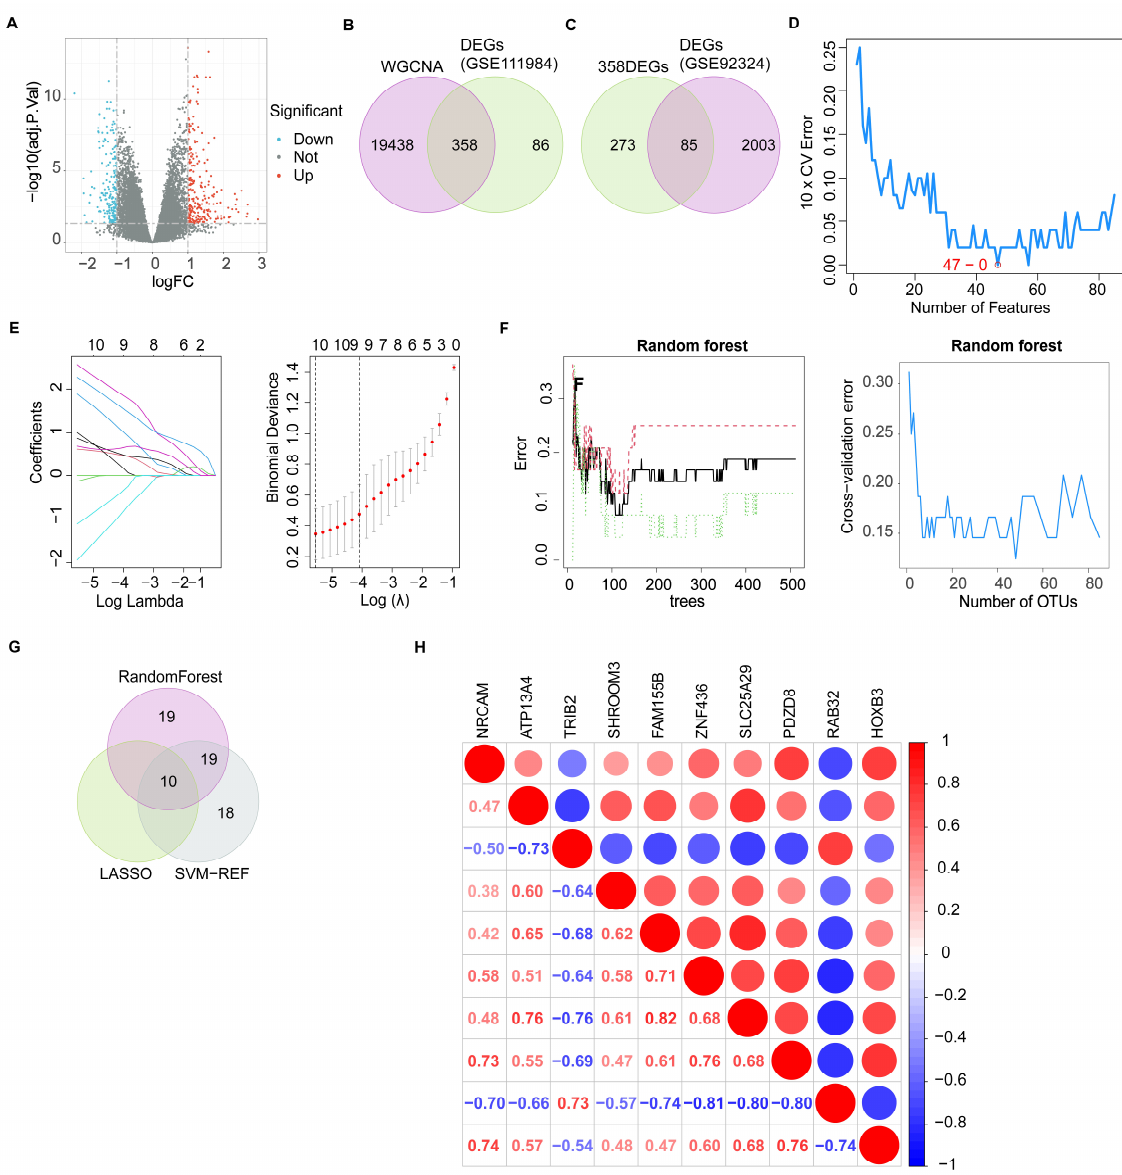
Figure 2. Identification of DEGs and screening of hub genes. ( A ) Volcano plot for DEGs in the GSE111974 dataset between RIF and healthy controls. ( B , C ) Venn diagram of preliminary gene screening. ( D ) SVM-RFE, ( E ) LASSO, and ( F ) RF analyses of the 85 DEGs. ( G ) Venn diagram of the ten hub genes. ( H ) Heatmap of the correlations between the hub genes. DEGs, differentially ex- pressed genes; RIF, recurrent implantation failure; SVM-RFE, support vector machine-recursive fea- ture elimination; LASSO, least absolute shrinkage and selection operator; RF, random forest.